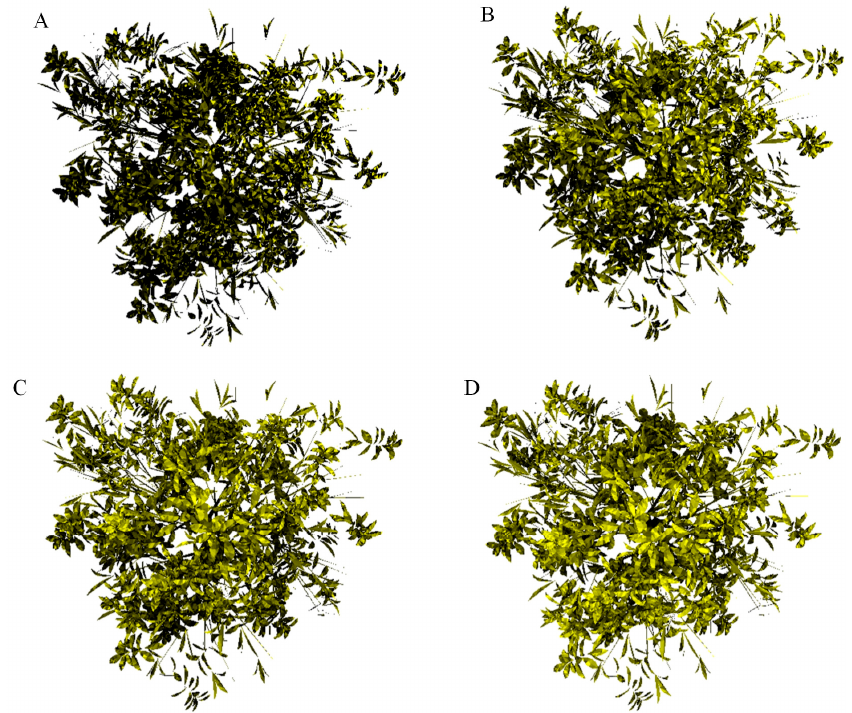
Figure 6. Schematic representation of light distribution variations within a canopy based on the number of light sources and iteration steps. The black triangles represent elements that have not received a photon flux, whereas the bright yellow triangles represent those receiving a photon flux. The brightness corresponds to the irradiation intensity. ( A ) Ten light facets; ( B ) fifty light facets; ( C ) one hundred light facets; and ( D ) two hundred light facets.